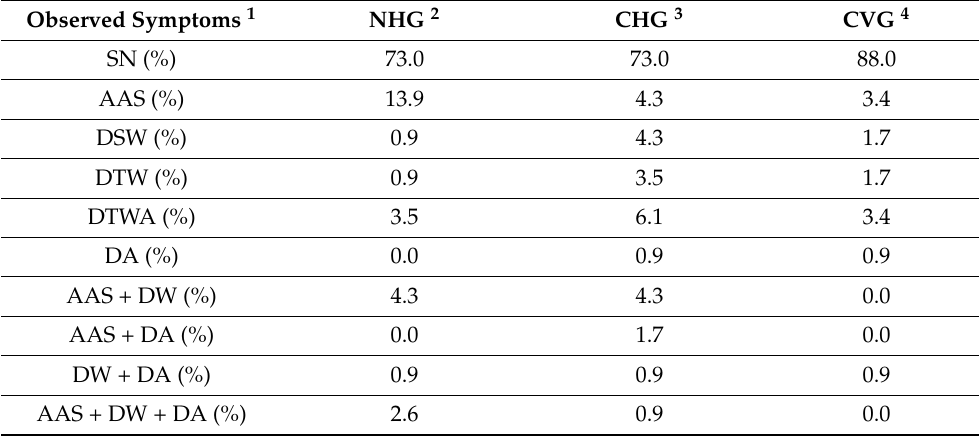
Figure 5. Percentage of observed symptoms of emerged bees. SN: survived and successfully